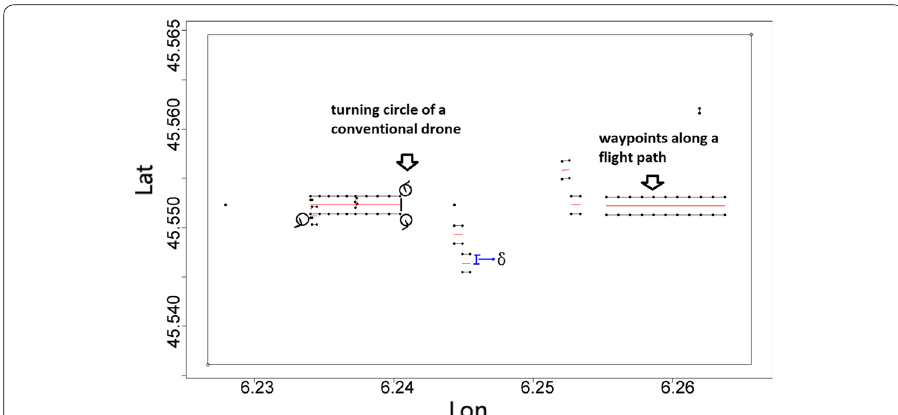
Fig. 6 Waypoints along network lines. δ represents the distance from the line for a subregion covered by a conventional drone